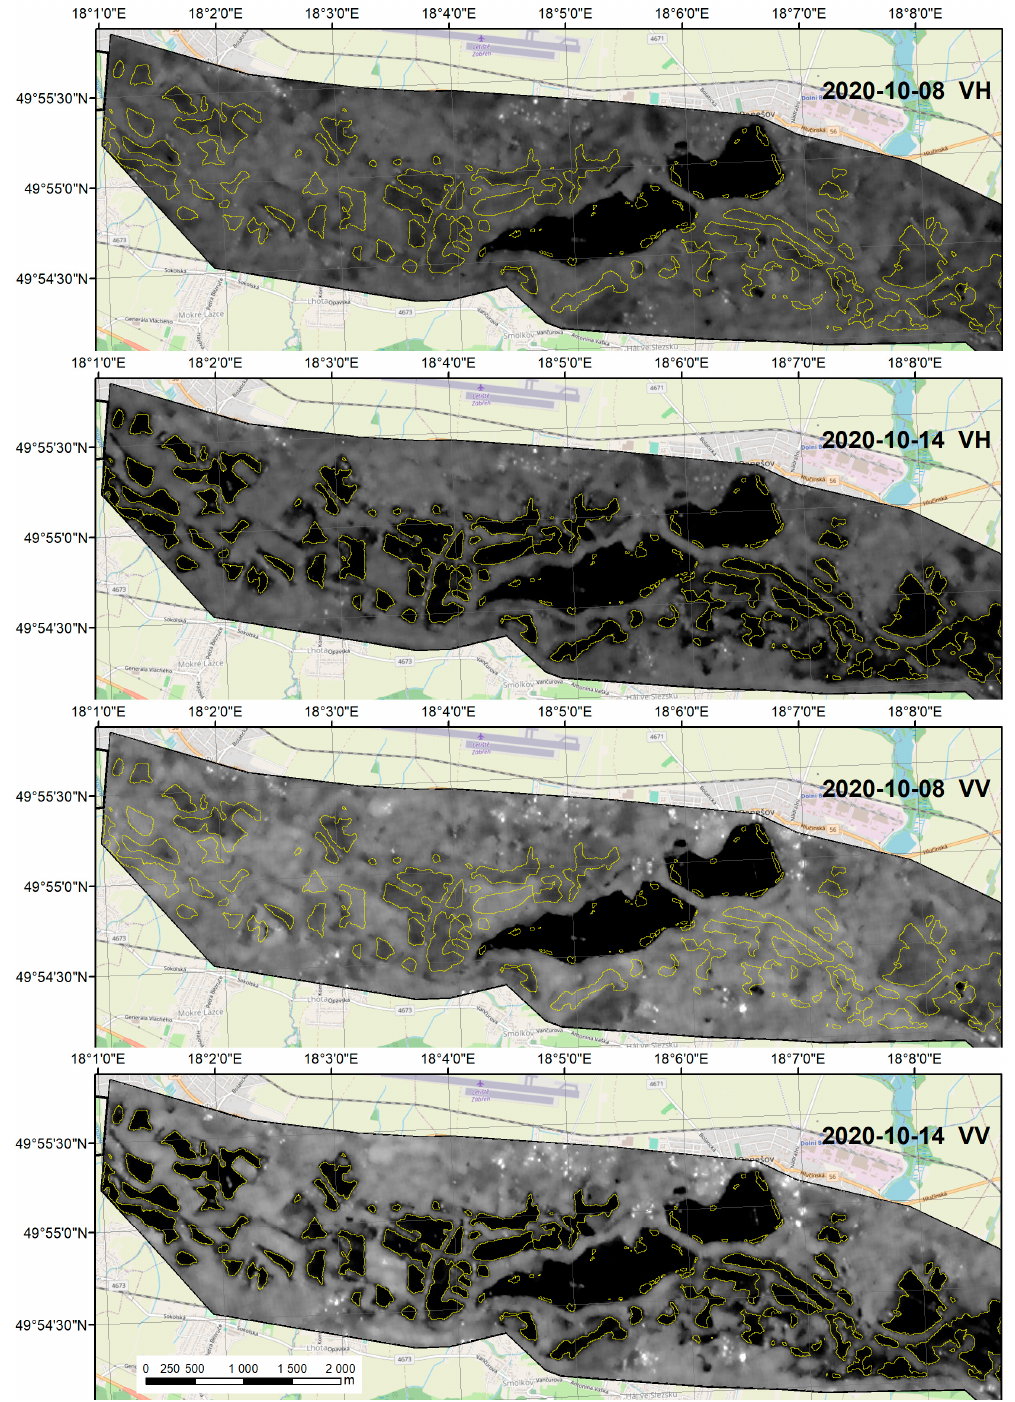
Figure 16. Sentinel-1 imagery from track A73 acquired during the flood event (14 October 2020) and before the flood event (8 October 2020) in the sub-area 2 (see Figure 14). Dates of image acquisition and data polarization are printed in each figure. The symbology is different for different data polarizations, black colour corresponds to − 26/ − 20 dB (VH/VV) or lower and white colour corresponds to +2/+1 dB (VH/VV) or higher. Areas identified as flooded by the developed solution from the Sentinel-1 data of 14 October 2020 are shown in yellow in all figures. Source of background map: Open Street Map (OSM).